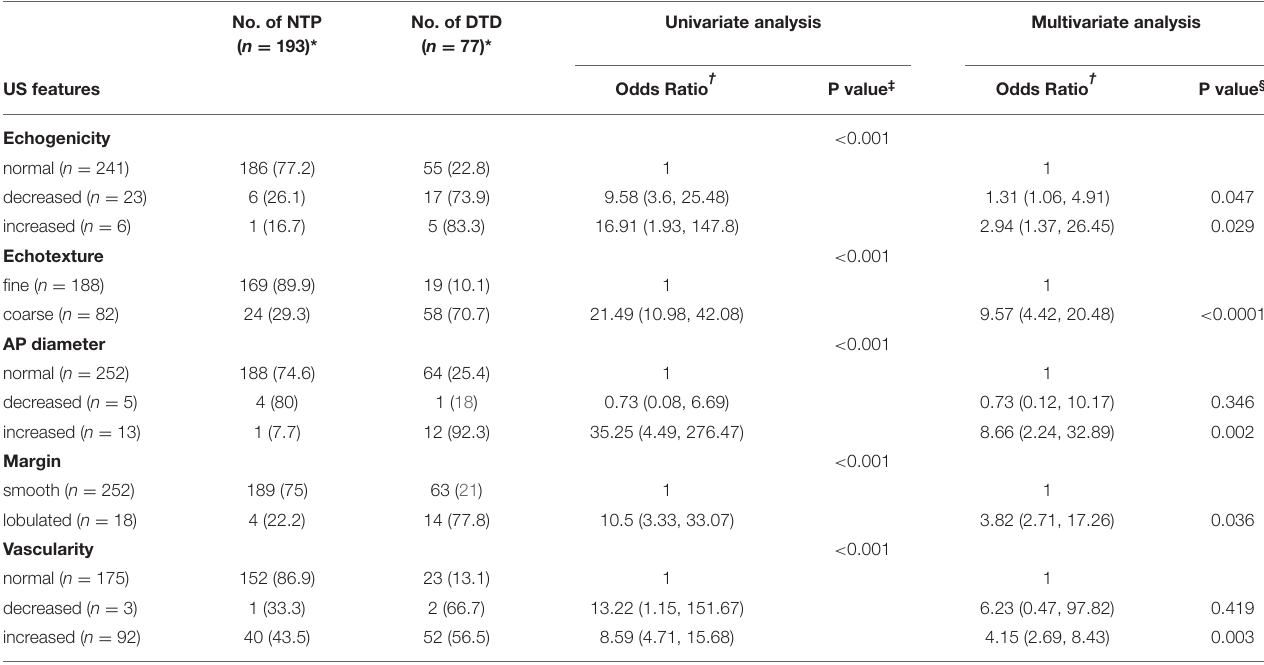
TABLE 1 | Association between various ultrasonography features and diffuse thyroid disease.